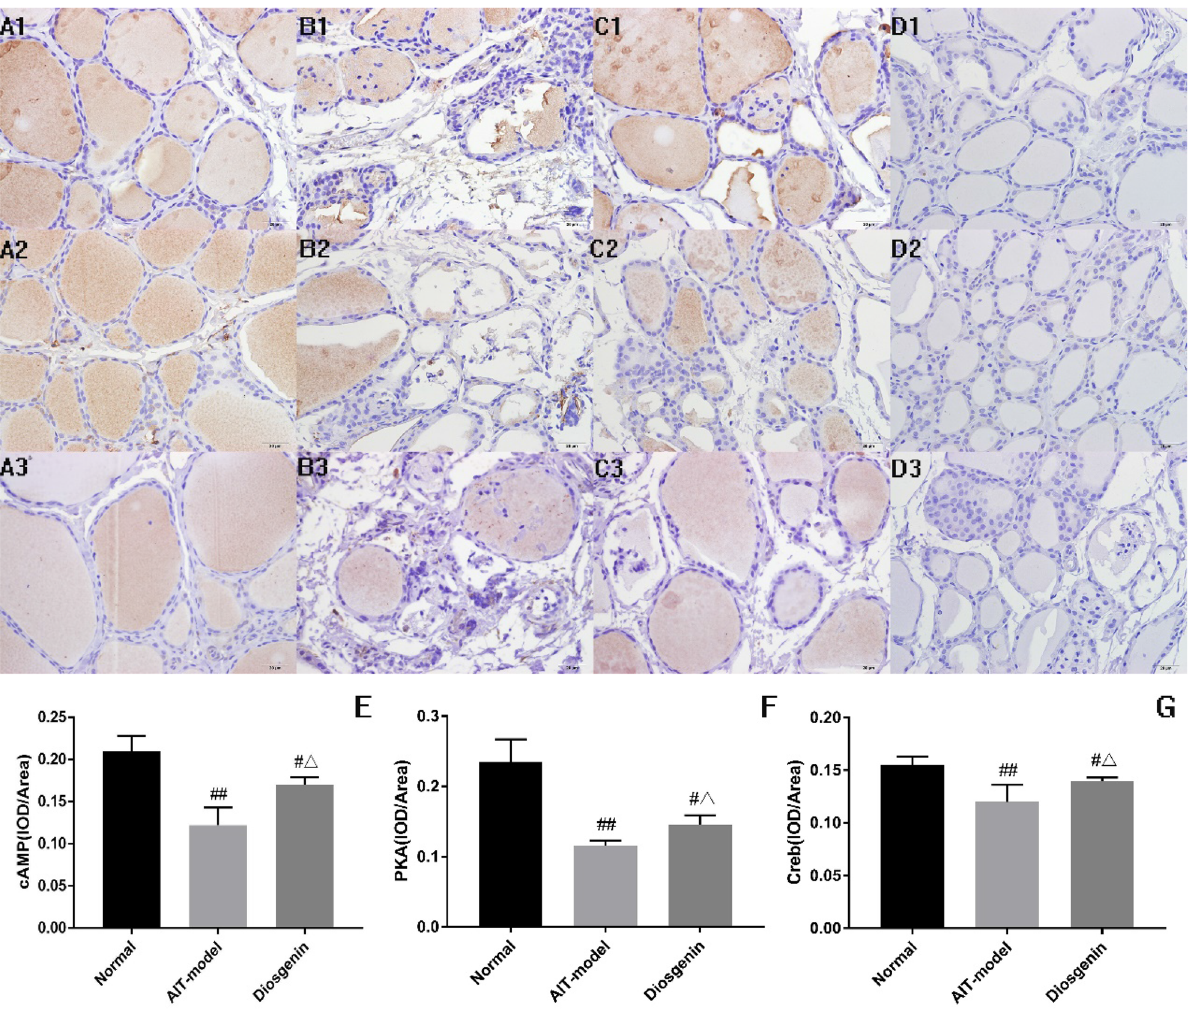
Figure 6. cAMP, PKA, and Creb protein levels in thyroid tissues shown by immunohistochemical staining. A1 – D1 : cAMP; A2 – D2 : PKA; A3 – D3 : Creb. A1 , A2 , A3 : normal control; B1 , B2 , B3 : AIT group; C1 , C2 , C3 : Diosgenin-H; D1 , D2 , D3 : Negative control staining.